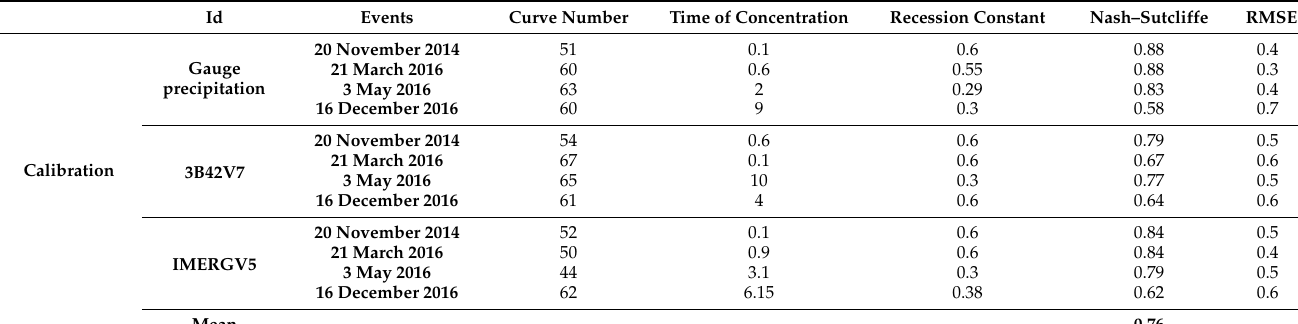
Table 5. Episodes calibration